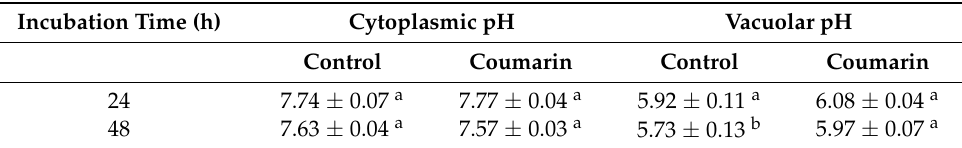
Data are expressed as mean ± SD. Data were analysed through two-way ANOVA using the LSD test as post hoc ( p ≤ 0.05). Different letters along the raws for cytoplasmatic pH and wacuolar pH indicate statistical differences among the treatments. N =